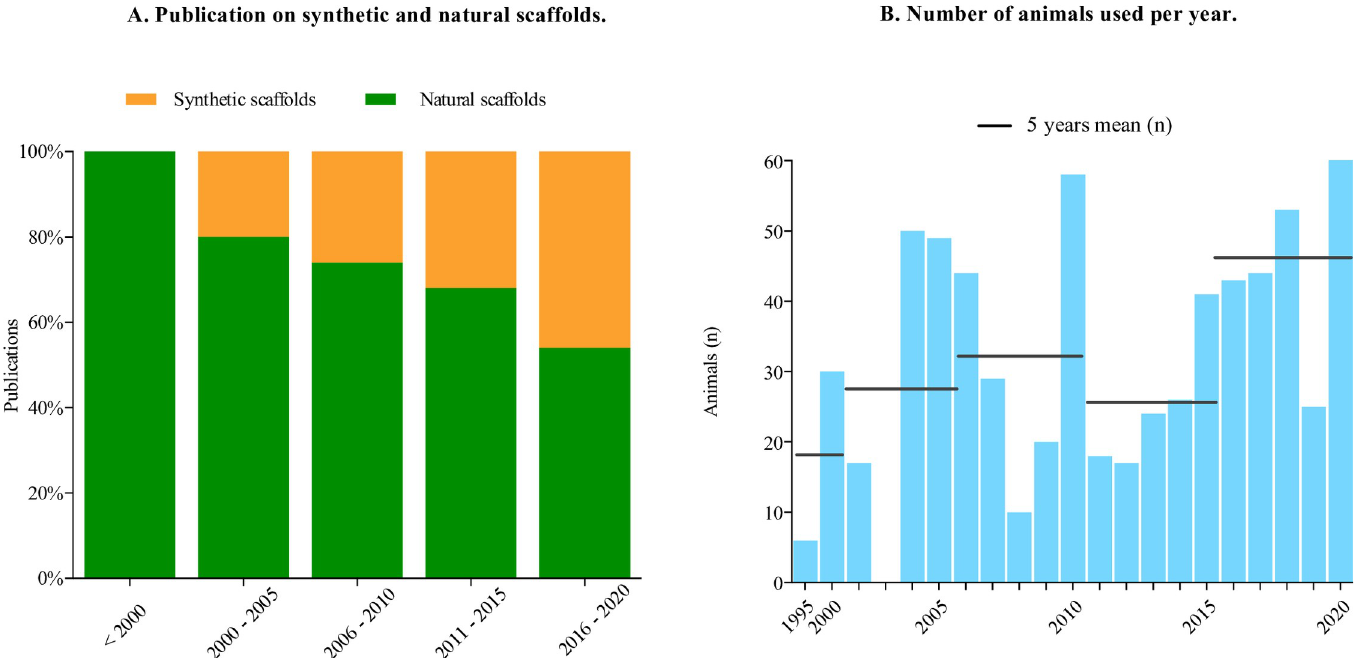
Fig 2. A. Percentage of publications of studies on TEHV scaffolds shifted from mainly natural-based scaffold designs before 2015, to synthetic scaffolds designs after 2015. B . Total number of animals used per year in studies on TE pulmonary valve implantations showed increase of (mean) numbers of animals over the last 20 years.